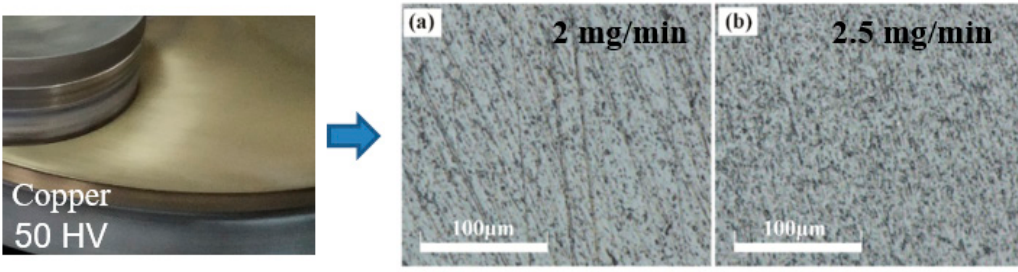
Figure 5. Optical images after lapping using cast iron pad: ( a ) common lapping; ( b ) ultrasonic-assisted lapping.